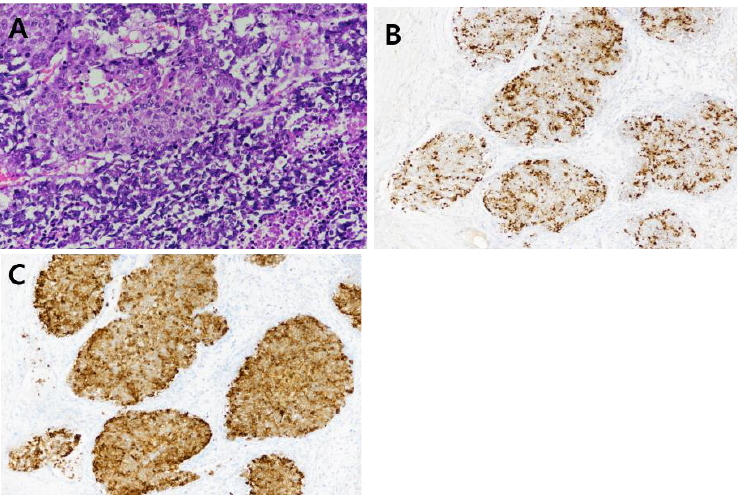
Figure 3. Microscopic findings. Hematoxylin and eosin stain demonstrated the intermingled HCC (top) and the large- and small-cell NEC (bottom) of the image ( A , magnification ×200). The NEC stains positive for chromogranin ( B , magnification ×100) and synaptophysin ( C , magnification ×100).